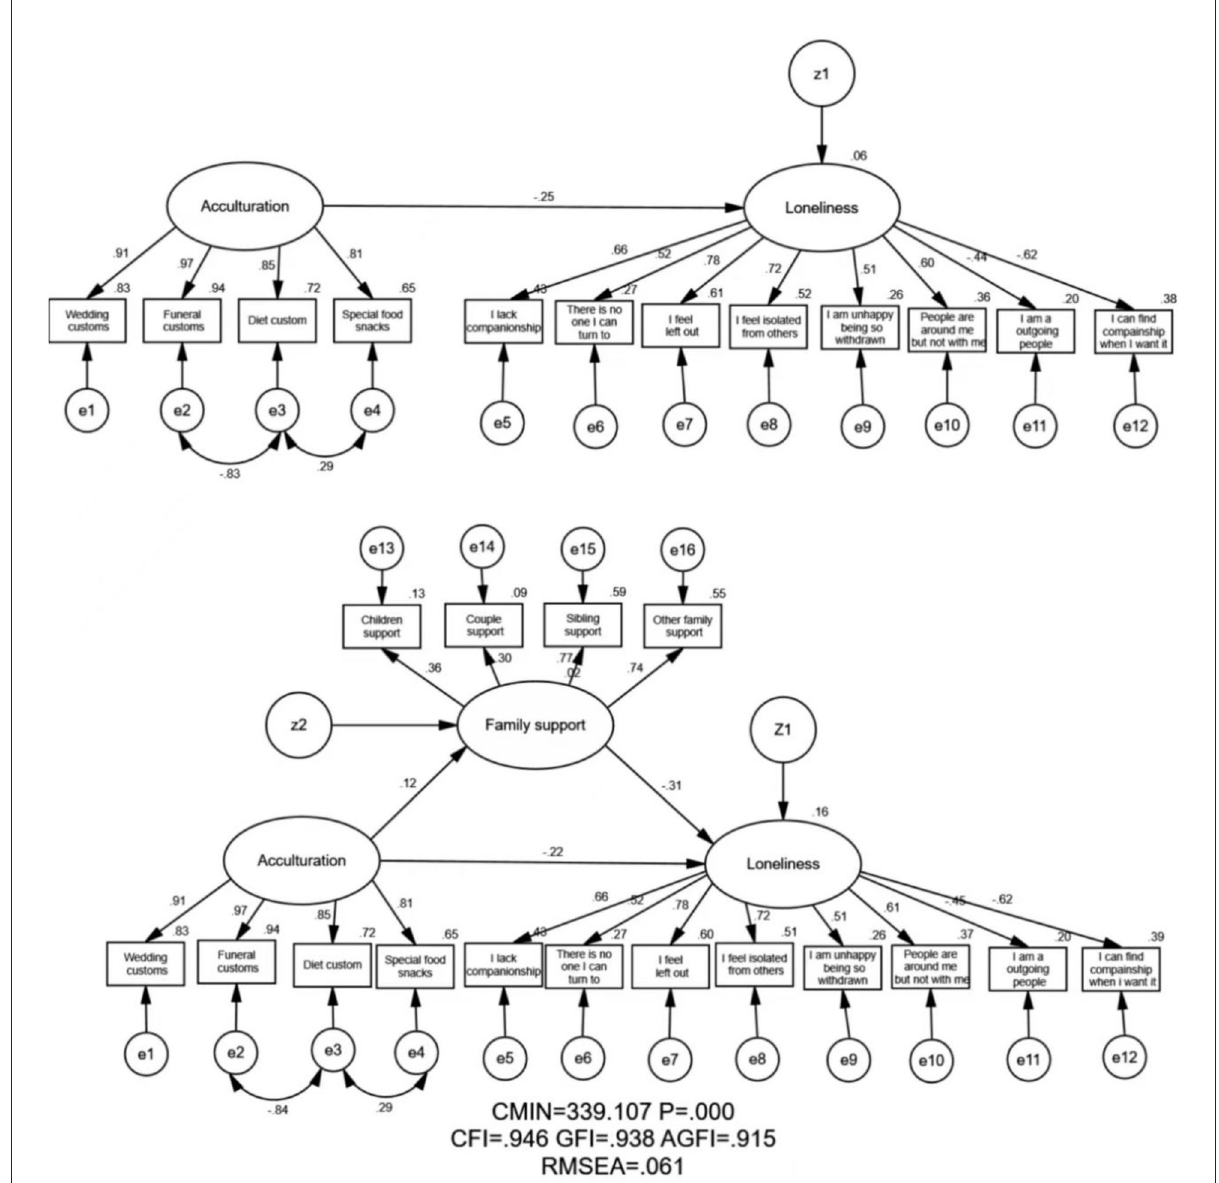
FIGURE1 Path diagram of the association between acculturation and loneliness with family support as a mediator ( n = 656). Employing the cross-sectional data, the relationship between acculturation and family support, and loneliness was analyzed. Arrows indicate the associations and directions between variables, and double curved arrows indicate the correlation between each factor. All parameter estimates were statistically significant ( p < 0.001); χ 2 = Chi-square; GFI, Goodness of Fit Index; AGFI, Adjusted Goodness of Fit Index; CFI, Comparative Fitness Index; RMSEA, Root-mean Square Error of Approximation; MEFC, migrant elderly following